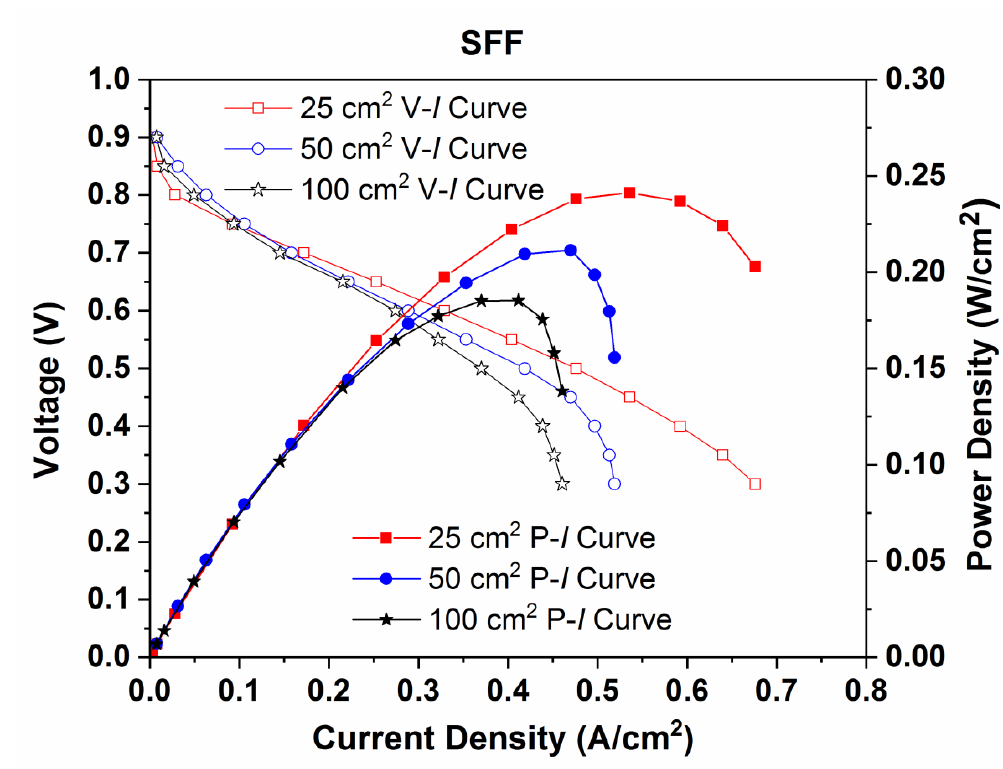
Figure 11. Performance (P–I) curves and Polarization (V–I) curves for PEMFC with reaction areas of 25, 50 and 100 cm 2 employing SFF.